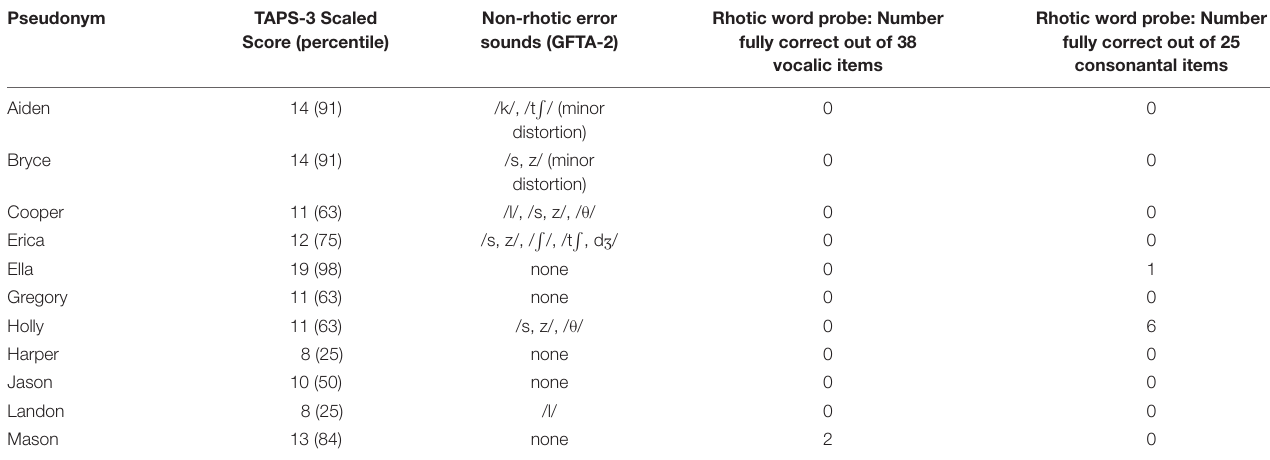
TABLE 2 | Participant evaluation